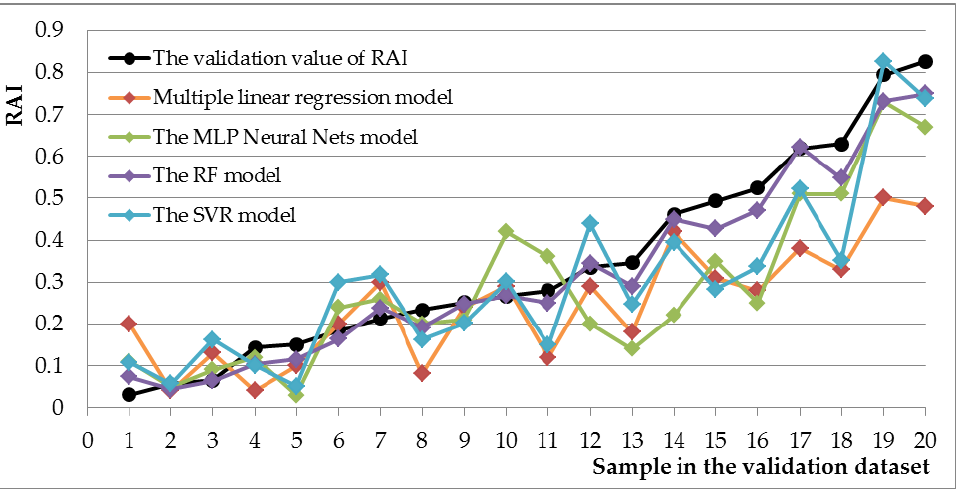
Figure 6. Comparison of the predicted RAI and the measured RAI